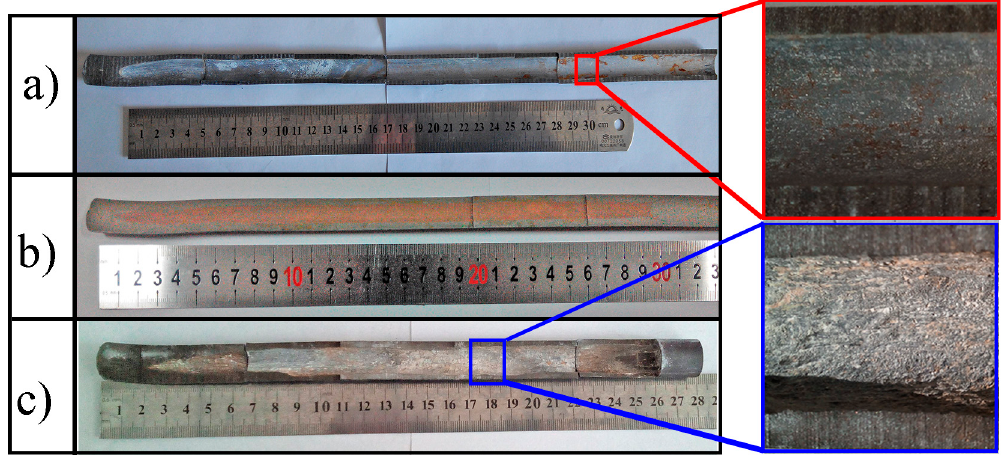
Figure 5. The cross-section of the extruded composite tubes with different filler materials: ( a ) 45 steel; ( b ) copper; ( c ) BN powder.